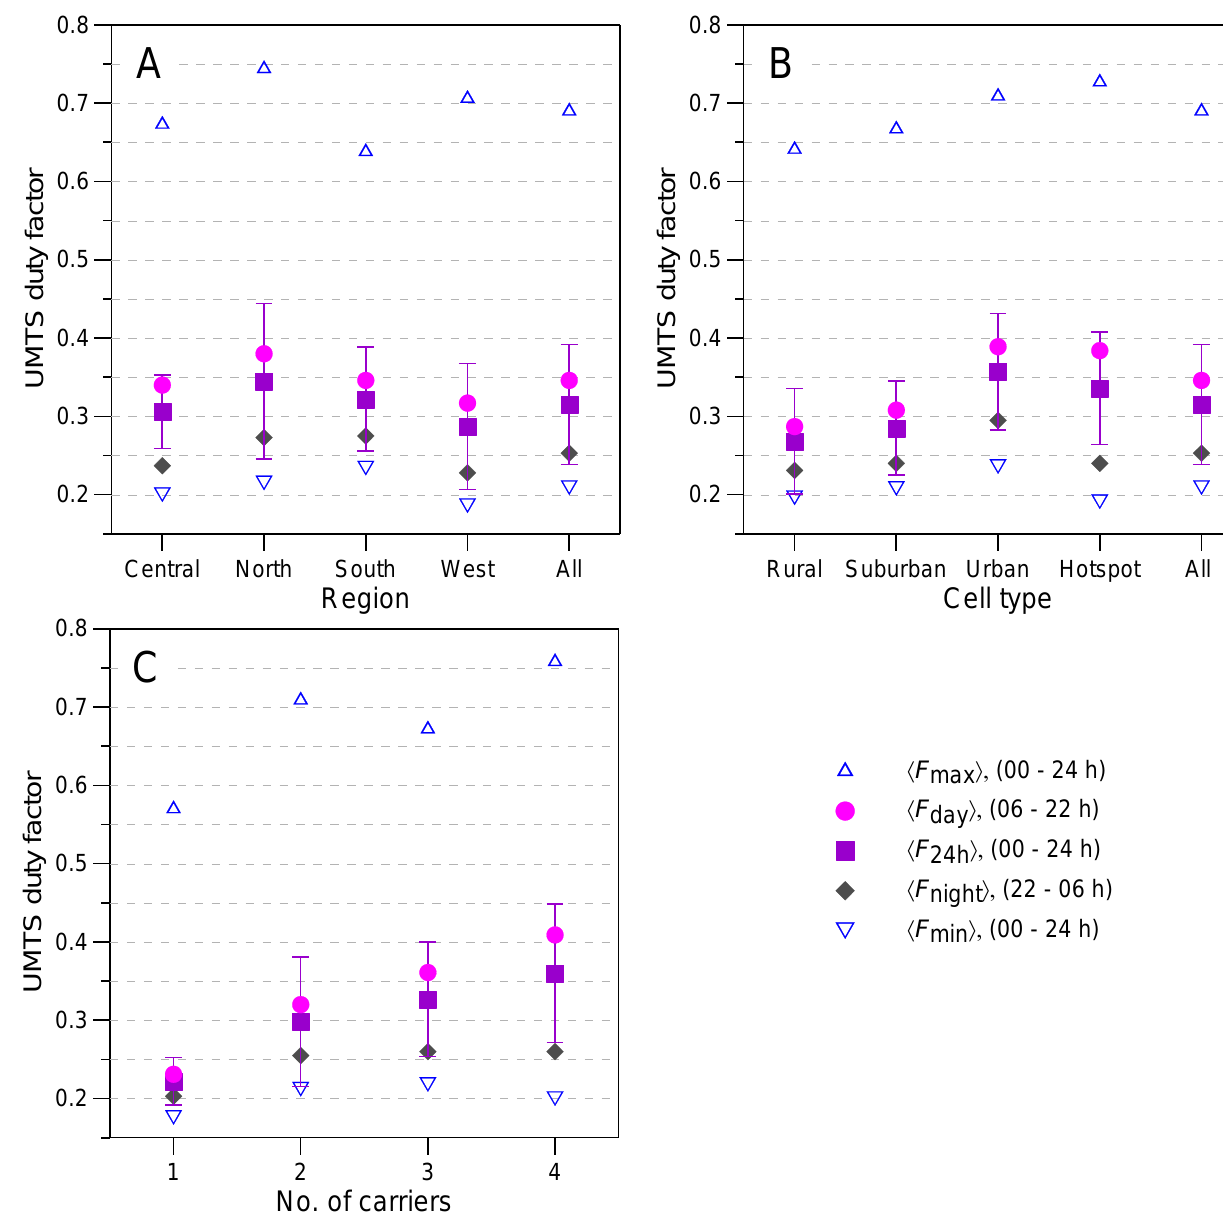
Figure 2. ( A ) (upper left): ERP duty factors, averaged over cells by region. ( B ) (upper right): ERP duty factors, averaged over cells by cell type. ( C ) (lower left): ERP duty factors, averaged over cells by number of carriers. Also shown is the standard deviation for 𝐹